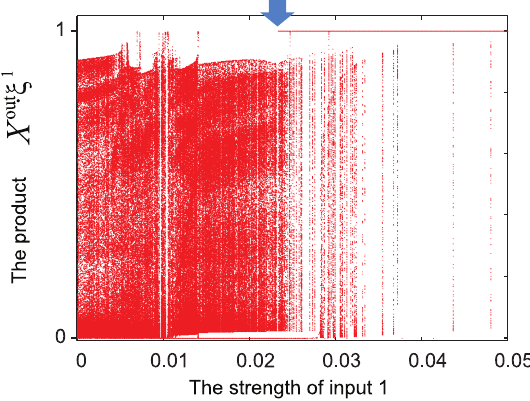
Figure 12. Bifurcation diagram through the input strength. The bifurcation diagram from the spontaneous limit cycle to the fixed point matching the target pattern is shown. The x-axis and the y-axis represent the strength of input, here, input 1 in Fig. 8, and the product between the neural activity in the output layer and the corresponding target. At each strength, we compute the neural activity evolving from an initial point chosen randomly and measure the product between the neural activity and the corresponding target for some constant time after transient time. Points representing values of this product are super-positioned at each strength. In the strength at more than 0.23 (see the arrow), the target is stable fixed-point attractor. In this area, both target fixed point and other attractors are stable, and at larger strength, only the former is stable, means this target is memorized in this network.